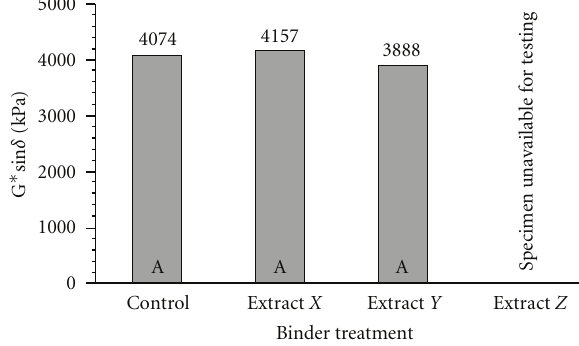
Figure 11: PAV aged G ∗ sin δ of control binder and binder with finish extracts tested at 25 ◦ C.